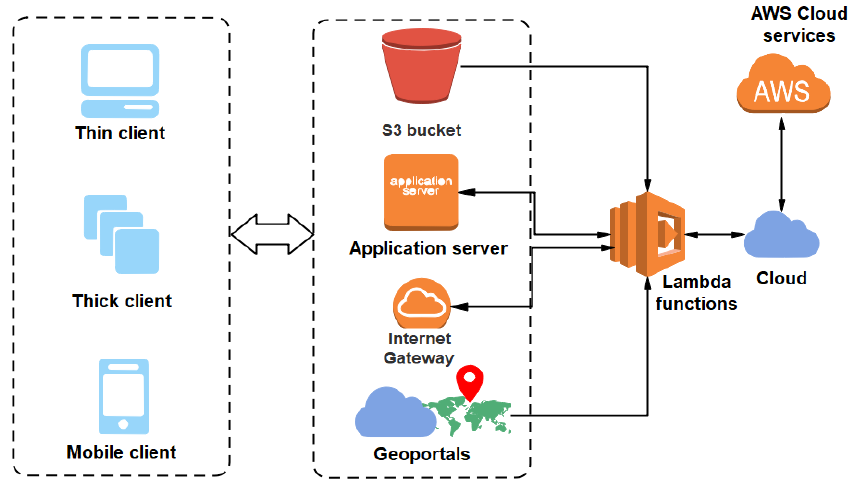
Figure 6. Serverless framework for geospatial data analytics with Amazon Web Services (AWS) Lambda embedded to perform specific geospatial data analytics activation